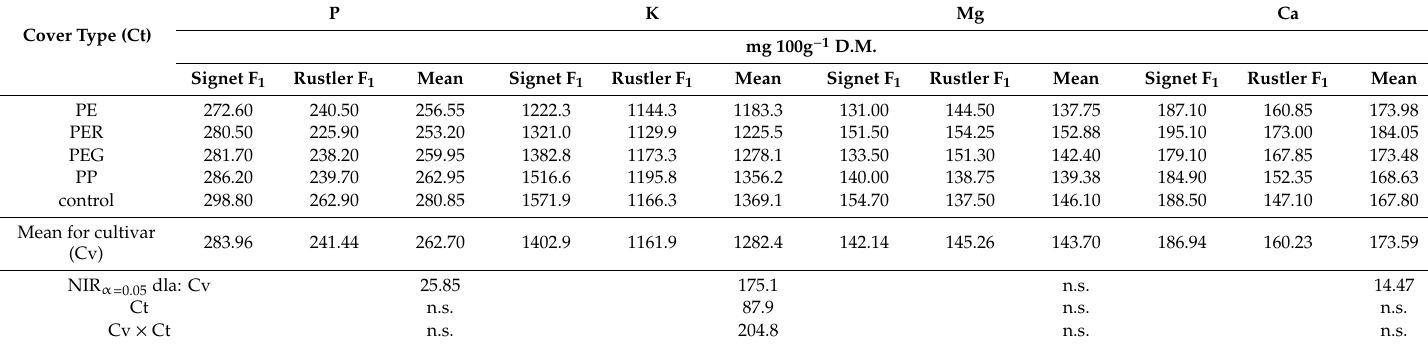
Table 8. Macro nutrients content in sweet maize grain depending on varieties and type of cover. Mean from the years 2012–2014. Cover Type